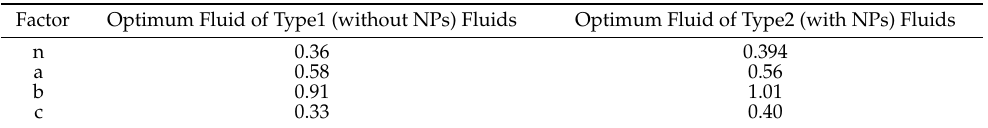
Table 7. The Factor of optimum fluids of type1 and type2 for pressure drop calculation during laminar flow in a